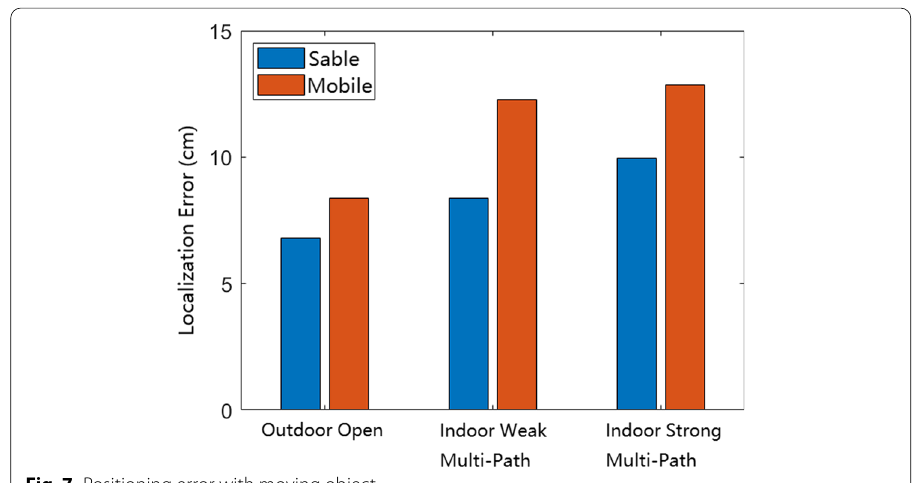
Fig. 7 Positioning error with moving